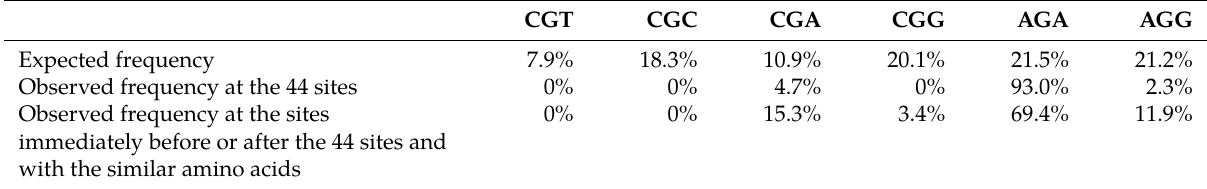
Table 2: The expected and observed frequencies of the six codons for the 2 nd amino acid Arginine (R2) in the protein se- quence in Figure 3C, and the observed frequencies of the six codons for R2 at the sites immediately before or after the 44 sites and with the similar amino acids in Figure 4D.